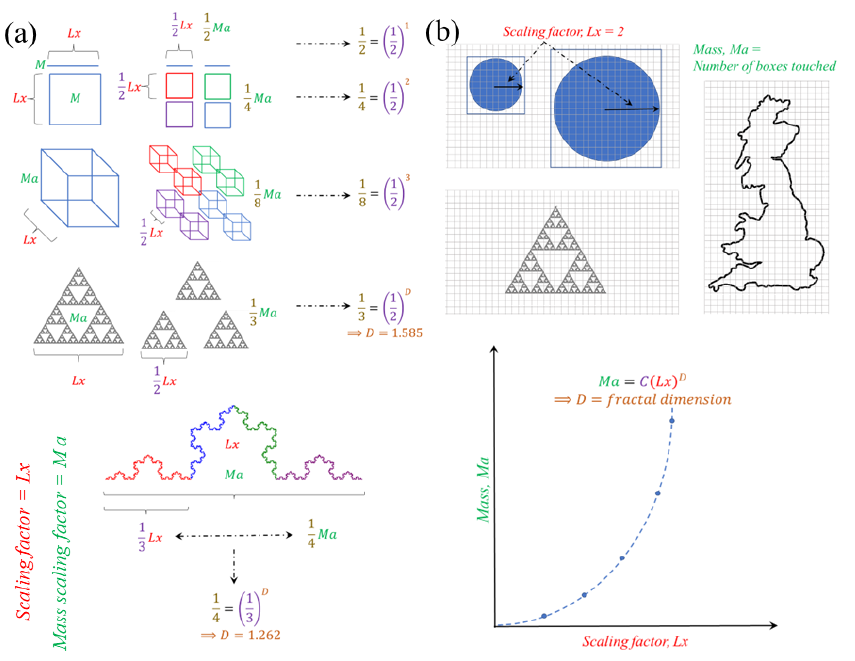
Figure 5. ( a ) Analogy of fractal dimensions with shape dimensions and ( b ) scale-wide generalization of fractal dimensions for various shapes